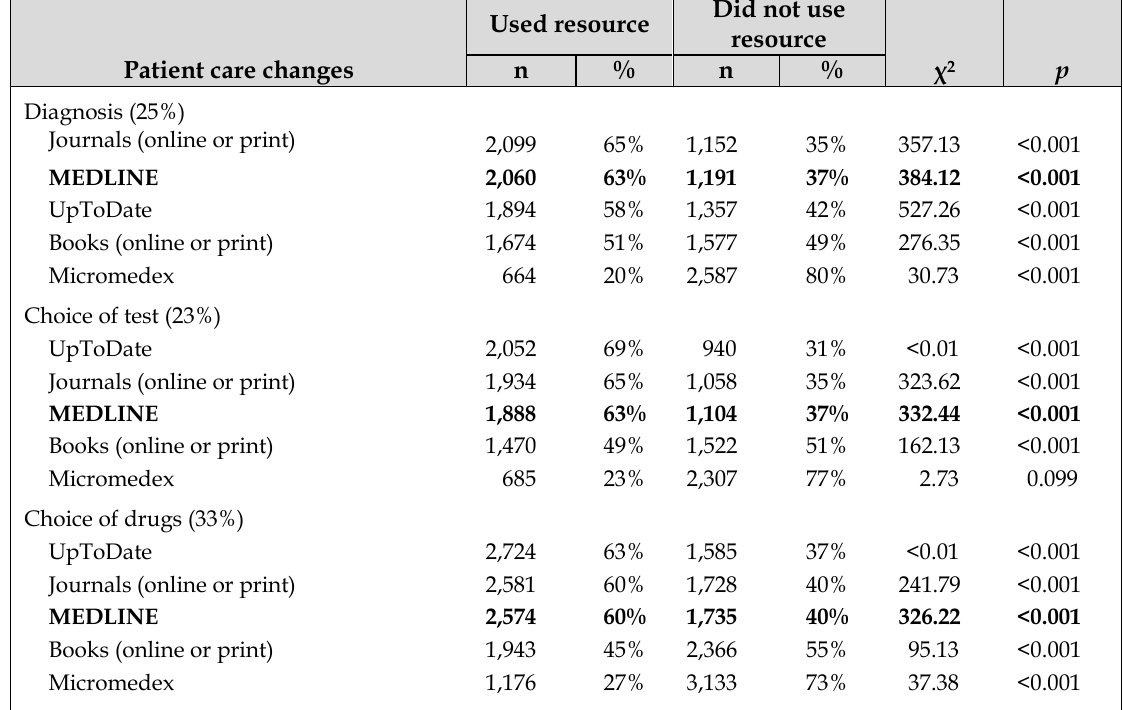
Table 2 Percent of respondents who used each information resource among those who made changes to patient care as a result of the information obtained in their